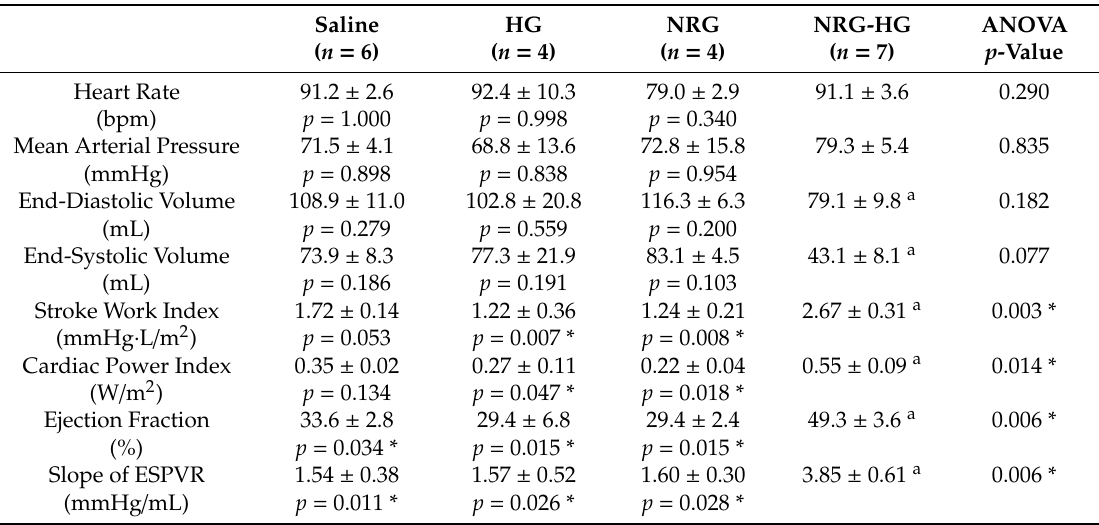
Table 1. Hemodynamics and cardiac function at 8 weeks after myocardial